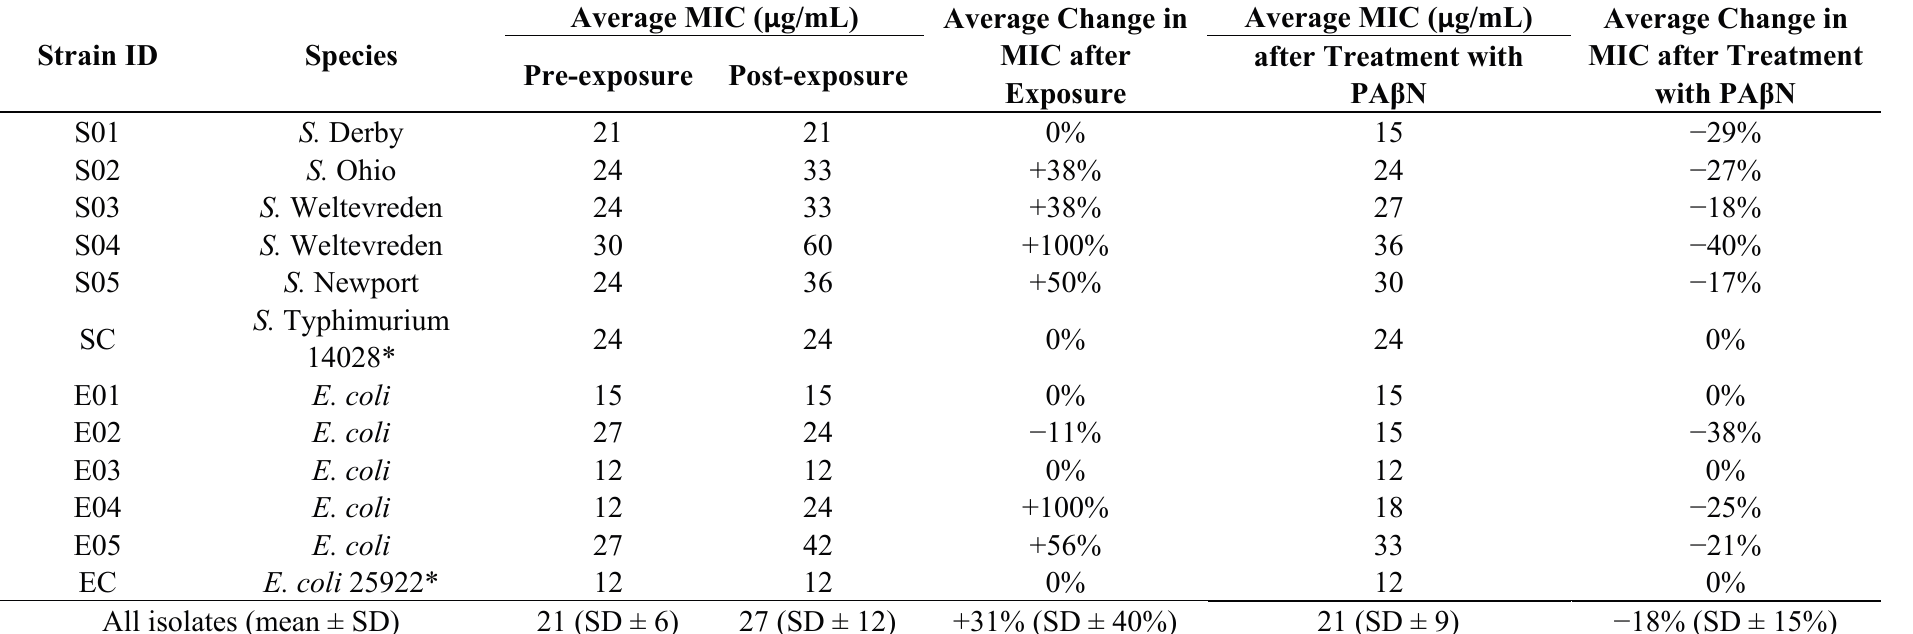
Table 1. Minimum inhibitory concentrations (MIC) against studied strains for Product A. Columns 3, 4, and 6 show MICs ( μ g/mL) pre-exposure, post-exposure, and after treatment with efflux pump inhibitor (PA β N). Column 5 shows changed MIC levels (%) after exposure to Product A compared with pre-exposure levels. Column 7 shows the average decreased MIC (%) after treatment with efflux pump inhibitor compared with post-exposure